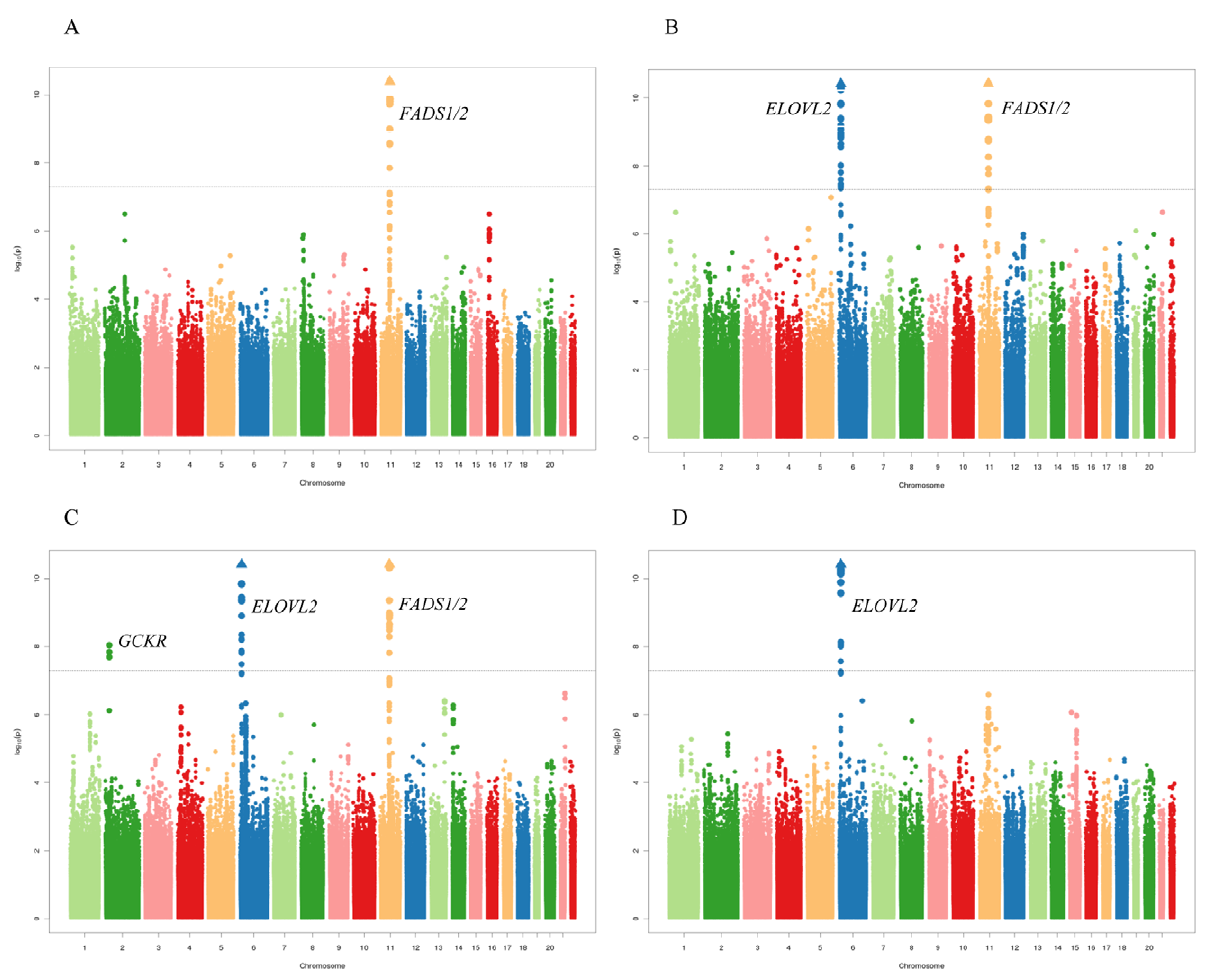
Figure 2. Meta-analysis of genome-wide associations with n-3 polyunsaturated fatty acids. A: a -linolenic acid (ALA), B: eicosapentaenoic acid (EPA), C: docosapentaenoic acid (DPA), D: docosahexaenoic acid (DHA). Associations were graphed by chromosome position and –log 10 (p-value) up to p-values of 10 2 10 . Triangles indicate additional SNPs with p-values less than 10 2 10 . Genes of interest in the regions with significantly associated SNP variants are